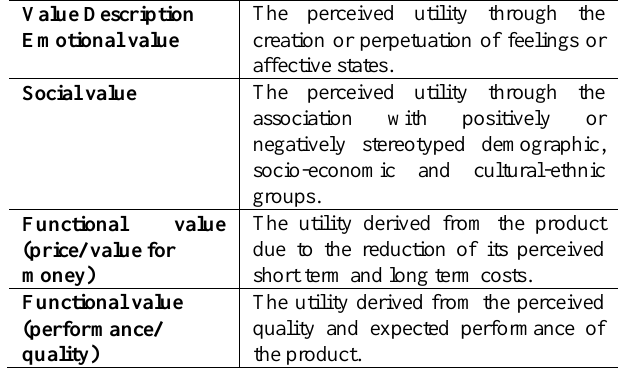
Table 1: The PERVAL